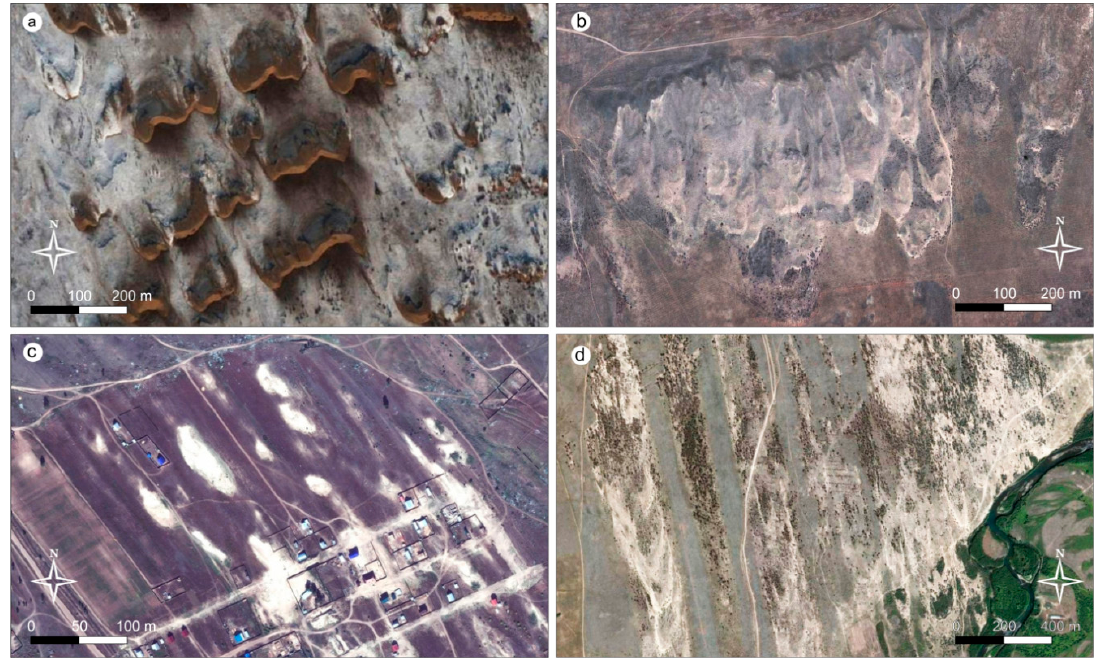
Figure 5. Deflation on abandoned croplands of the Selenginskii District: a —dunes at the place of abandoned croplands in the 1950s (winter photo); b —deflated surface of the Jida river; c —areas of sand fluttered in the suburb of Ulan-Ude; d —fields destroyed by wind erosion in the Kyakhta District.